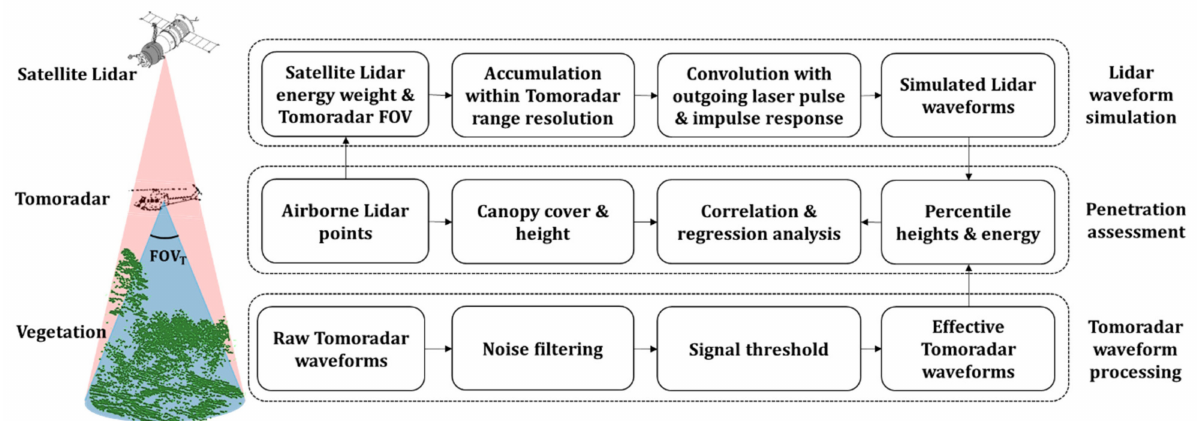
Figure 2. The flowchart of the penetration investigation of the Ku-band microwave and near-infrared laser at the same spatial scale based on the percentile heights and energy. The procedure includes three processing steps: simulating satellite lidar waveforms from lidar points, assessing penetration and processing Tomoradar waveforms. The symbol of FOV T represents the Tomoradar